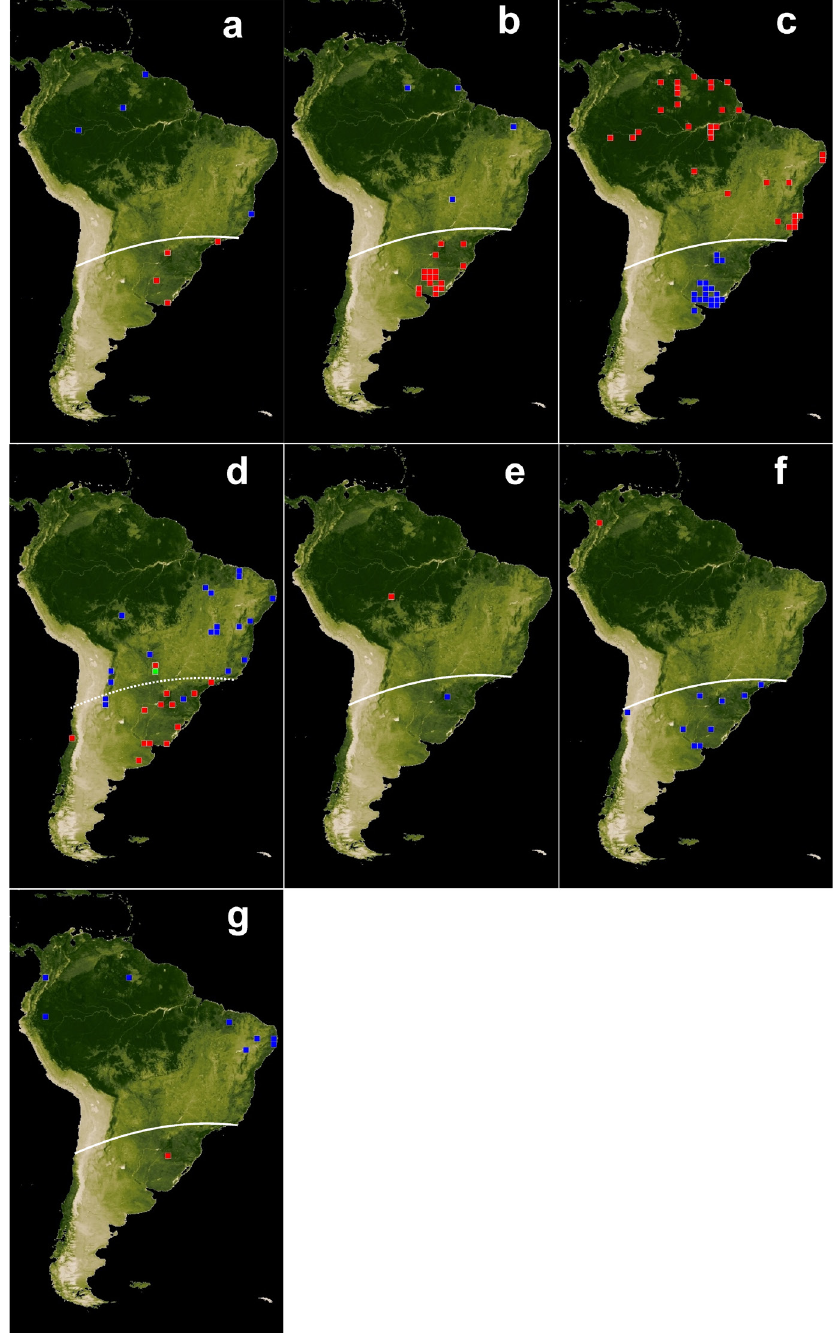
Figure 2 - SVe2 (Supported Vicariant event 2): (a) Asthenopodes chumuco (blue) and A. traverae + A. picteti (red); (b) Campsurus amapaensis (blue) and C. major + C. argentinus (red); (c) Homothraulus (blue) and Simothraulopsis (red); (d) Callibaetis sellacki +C. fasciatus (red) and C. pollens + C. dominguezi + C. capixaba + C. cochlea (blue); (e) Callibaetis itannae (red) and C. calophenigyn (blue); (f) Callibaetis molinerii (red) and C. jocosus (blue); (g) Caenis gaucha (red) and C. chamie (blue). White lines are for visual reference (they are located in the same place in all the